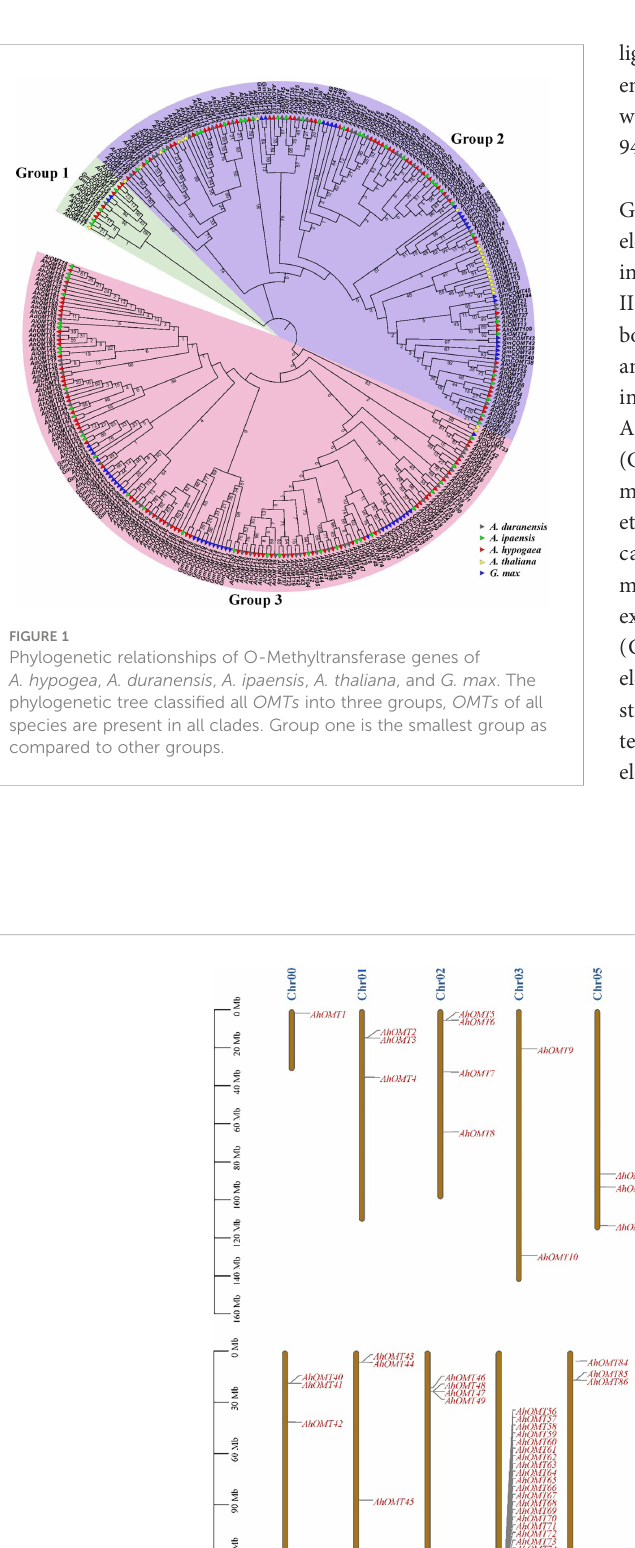
FIGURE 2 Chromosomal distribution of AhOMTs genes. The highest number of AhOMTs on A-subgenome were present on Chr07 (15 genes) and in B-subgenome on Chr14 (28 genes) and Chr17 (16 genes), and all other chromosomes possessed varying numbers of OMT